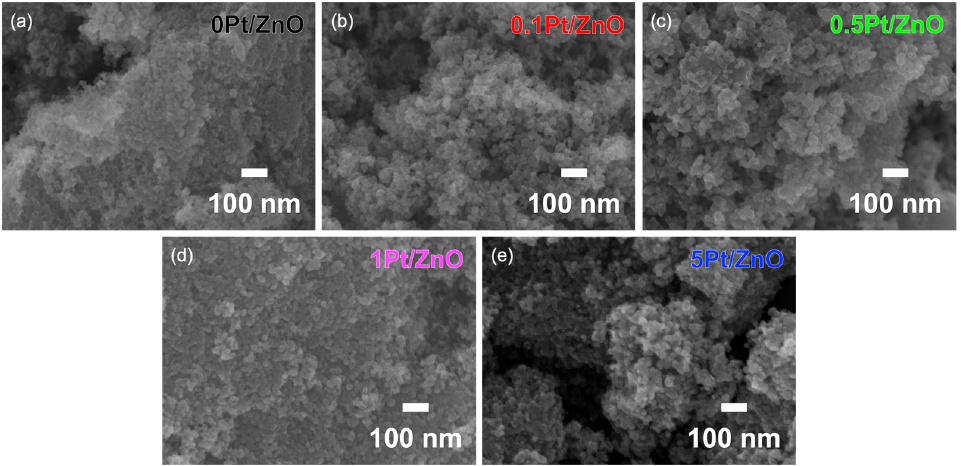
Figure 4. FE-SEM images of gas sensing films fabricated using ( a ) 0Pt/ZnO; ( b ) 0.1Pt/ZnO; ( c ) 0.5Pt/ZnO; ( d ) 1Pt/ZnO; ( e ) 5Pt/ZnO NCs.